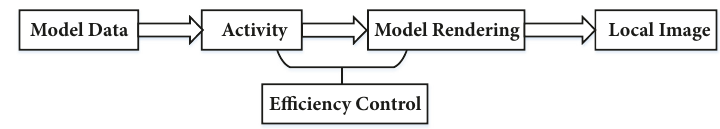
Figure 1: Group rendering process.